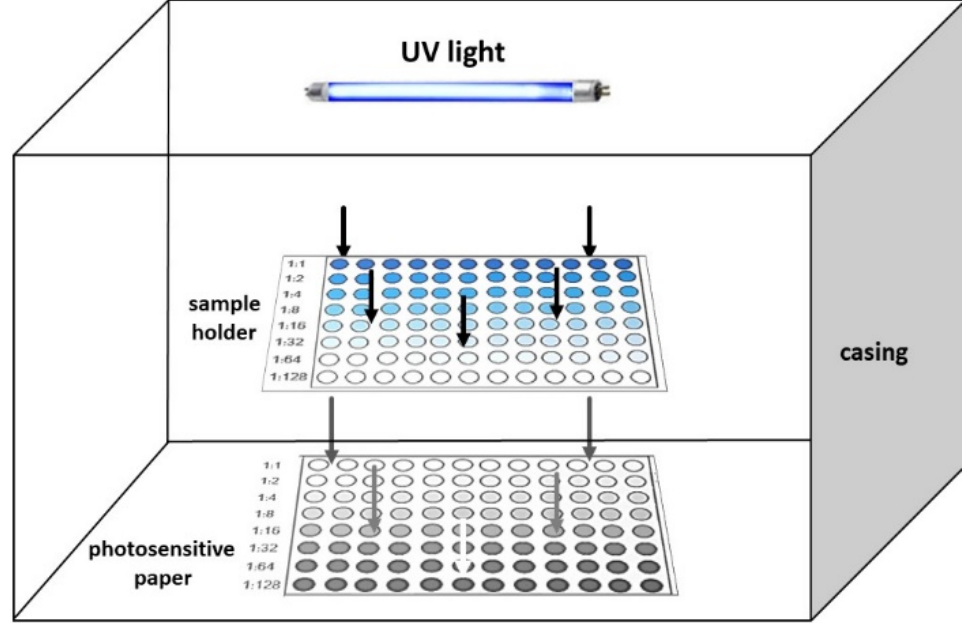
Figure 1. Illustration of the setup and operation of a photographic-based photometry